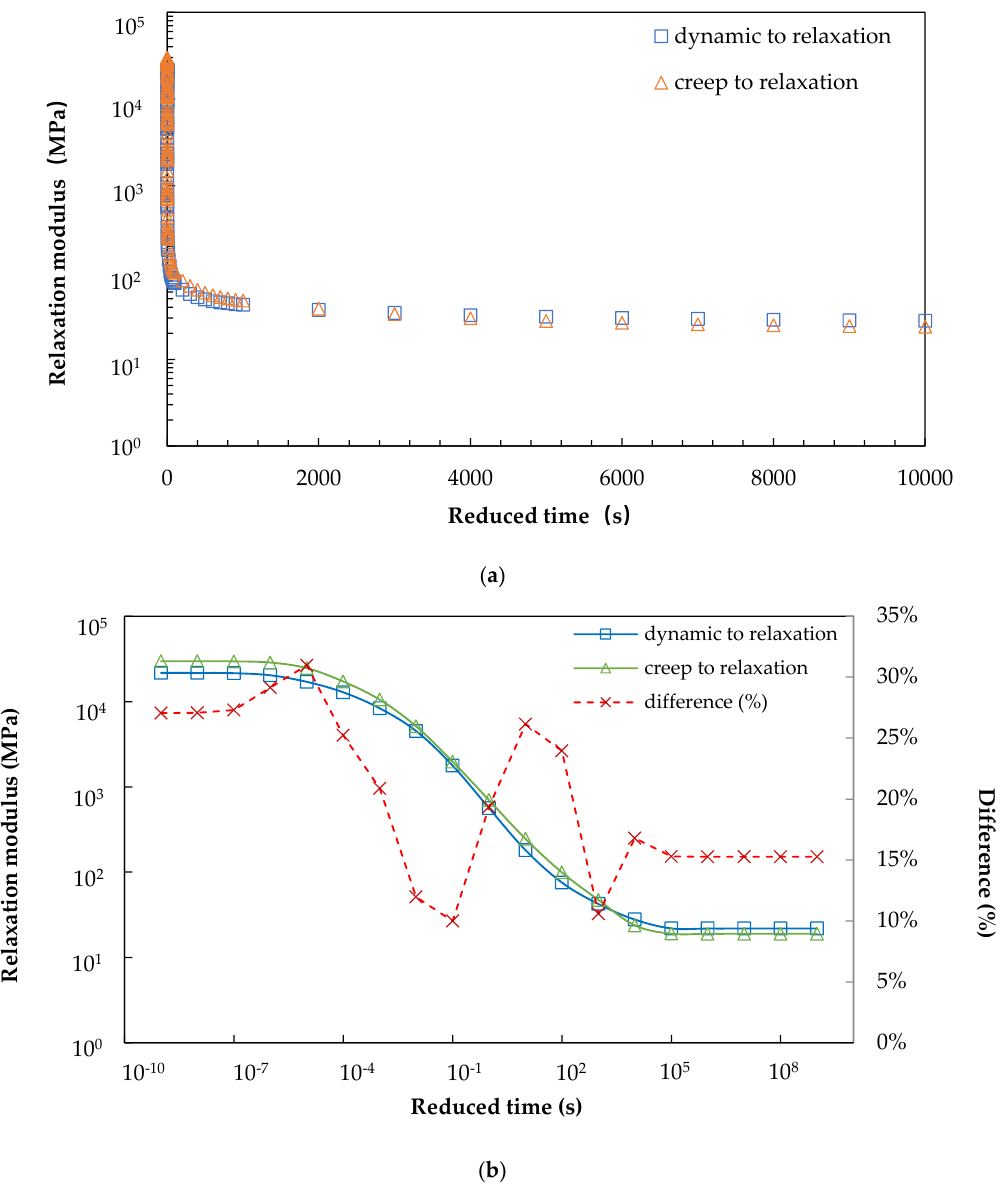
Figure 5. Relaxation modulus master curve converted from dynamic modulus and creep compliance ( a ) in semi-log scale, and ( b ) in log-log scale.